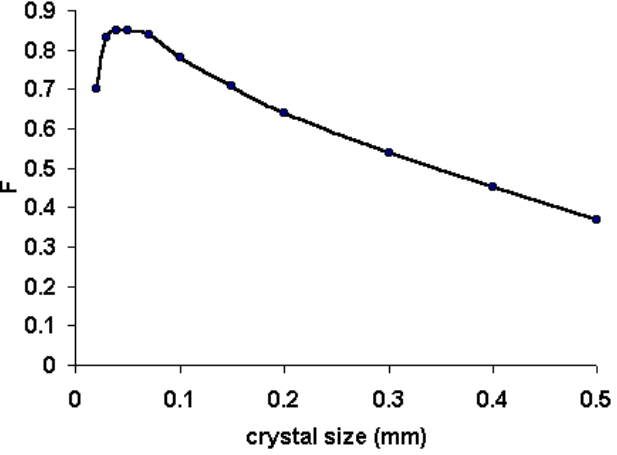
FIG. 2. (Color) Efficiency of crystal multipass scraping for the 1 GeV particles that were not channeled on the first encounter, as a function of the crystal size along the